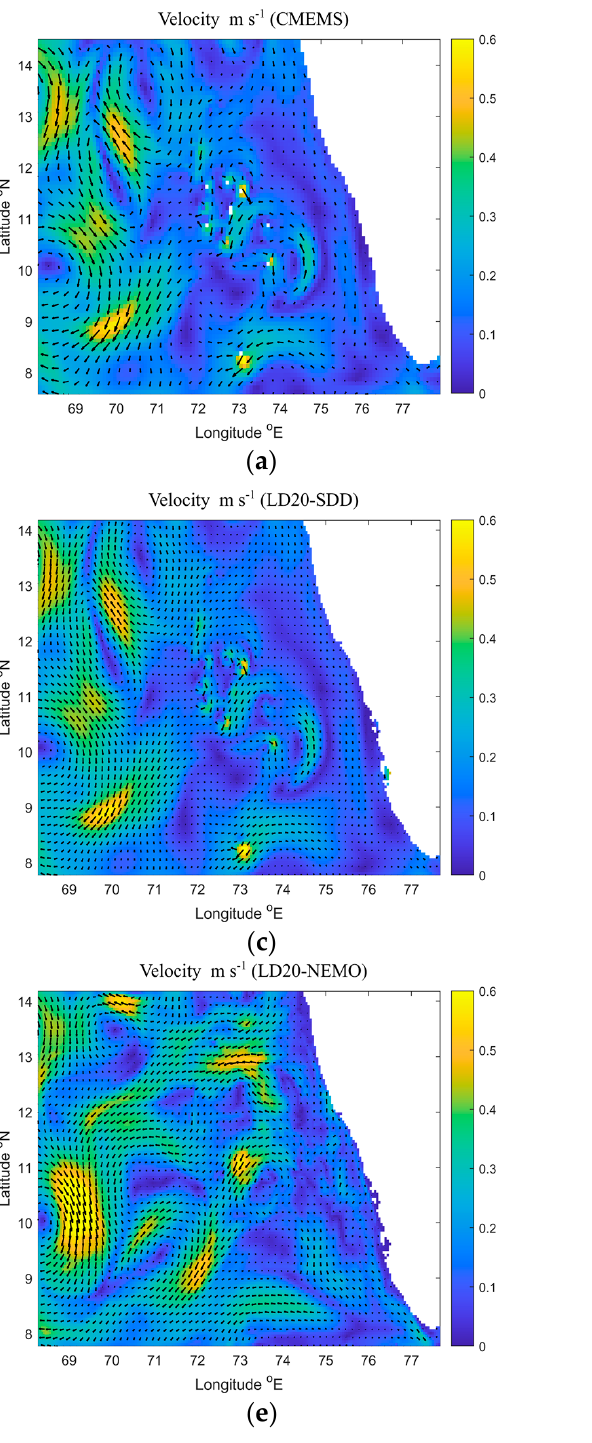
( f ) Figure 6. Comparison of temperature (left panels) and salinity (right panels) profiles from CMEMS, LD20-NEMO and LD20-SDD models, with respect to ARGO float observations: ( a , b ) Bias; ( c , d ) RMSD; ( e , f ) RMSDA. The period of averaging is from 1 January 2015 to 31 December 2018.